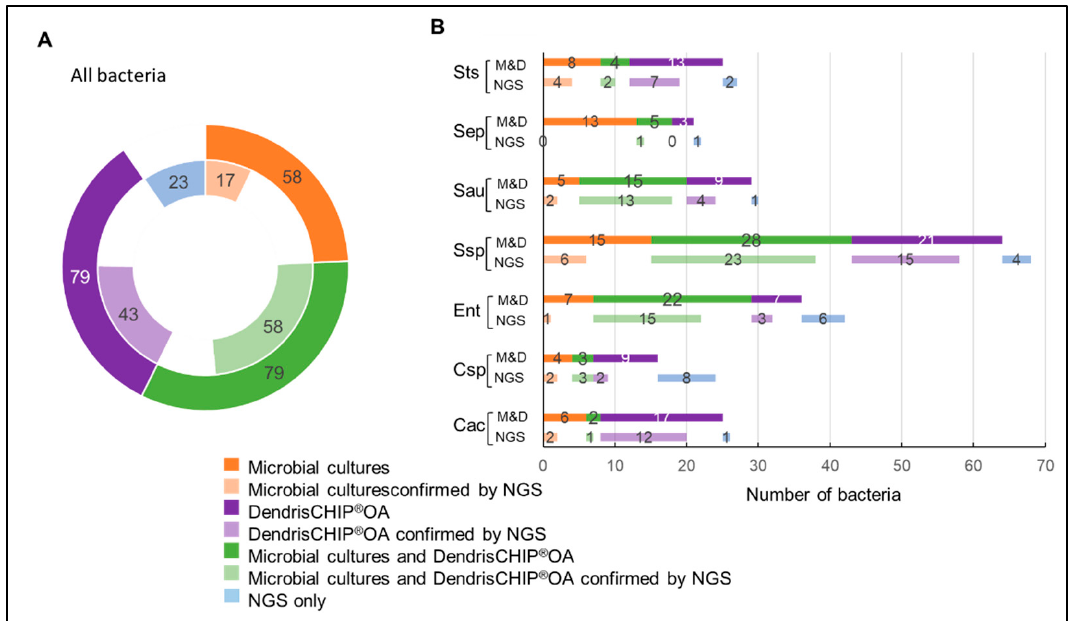
Figure 2. Comparison between molecular methods and microbial cultures for identification of bacteria in isolates. A total of 101 samples were sequenced, giving rise to a total of 141 identified bacteria by NGS according to criteria defined in Materials and Methods. The identified bacteria were compared with those identified by DendrisCHIP ® OA and microbiological methods in ( panel A ). Comparison at the level of single bacteria species between the three methods is reported in ( panel B ). The abbreviation for bacteria can be found in Table 1.